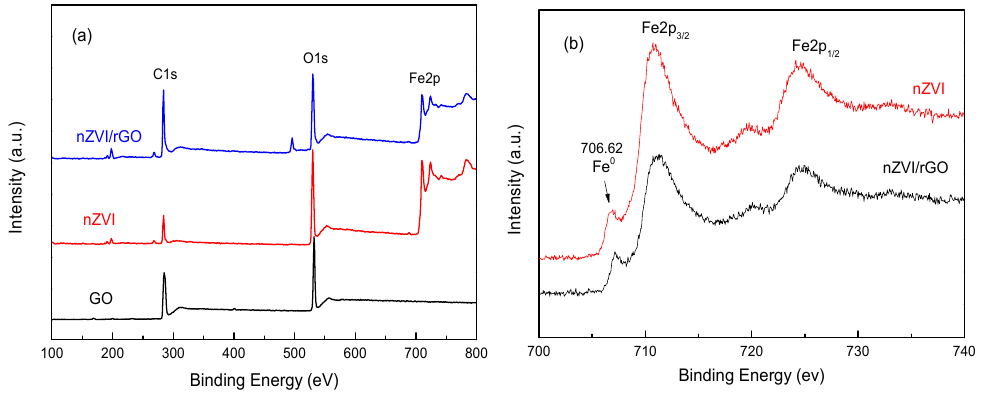
Figure 7. X ‐ ray photoelectron spectra (XPS) analyses of nZVI and nZVI/rGO: wide scan ( a ); High resolution spectra of Fe2p in lab made nZVI ( b ).